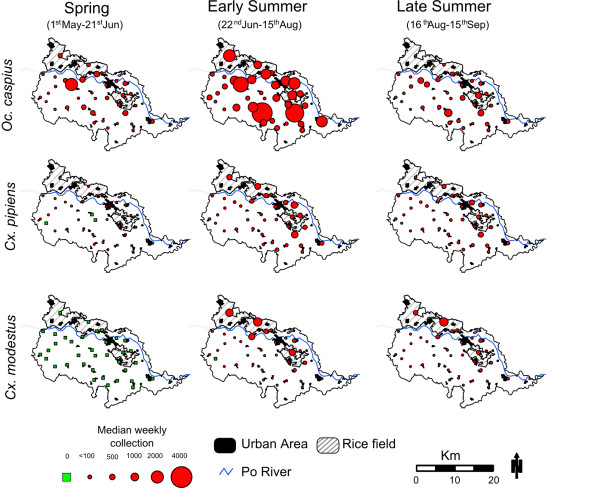
Spatial pattern of the number of adult mosquitoes collected, by species, during 2000 to 2006 in the eastern Piedmont Region, Italy. Median of weekly collection (red circles), and the traps that have median collection equal 0 (green triangles). The urban areas and rice fields were also included.